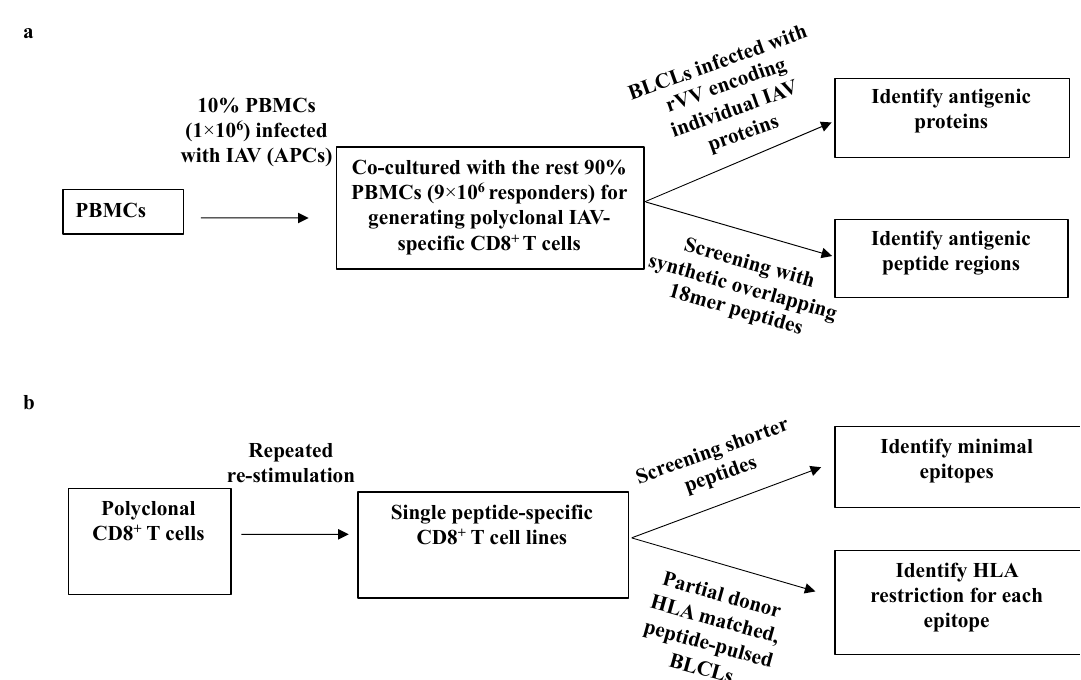
Figure 1. A systematic approach for identifying IAV-specific CD8 + T cell responses. ( a ) Establishing polyclonal IAV-specific CD8 + T cells. After two weeks culture, CD8 + T cells were screened by a panel of individual IAV proteins encoded by rVV to identify specific antigenic proteins. After knowing the specific antigenic protein, CD8 + T cells were screened with synthetic overlapping 18mer peptides to determine the specific antigenic peptide regions within the protein. ( b ) Generating individual peptide-specific CD8 + T cell lines using individual peptide-pulsed APCs to expand IAV-specific CD8 + T cells enriched via CD3CD8 downregulation-guided sorting. Two weeks later, CD8 + T cells were tested with shorter peptides to assess the core sequence and HLA restriction of each particular epitope.